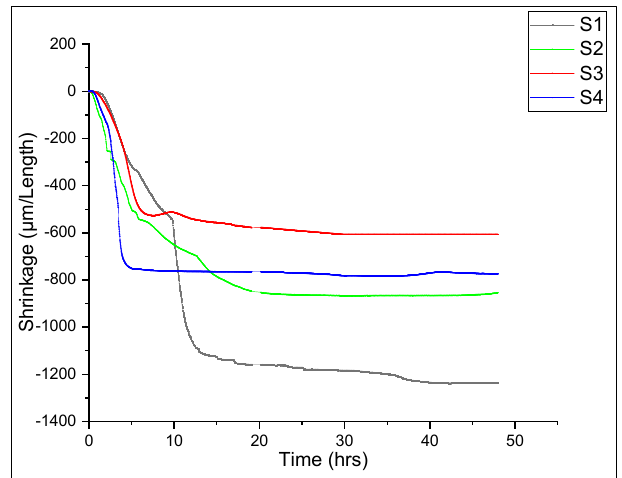
Figure 13. Shrinkage measurement of SCCM.